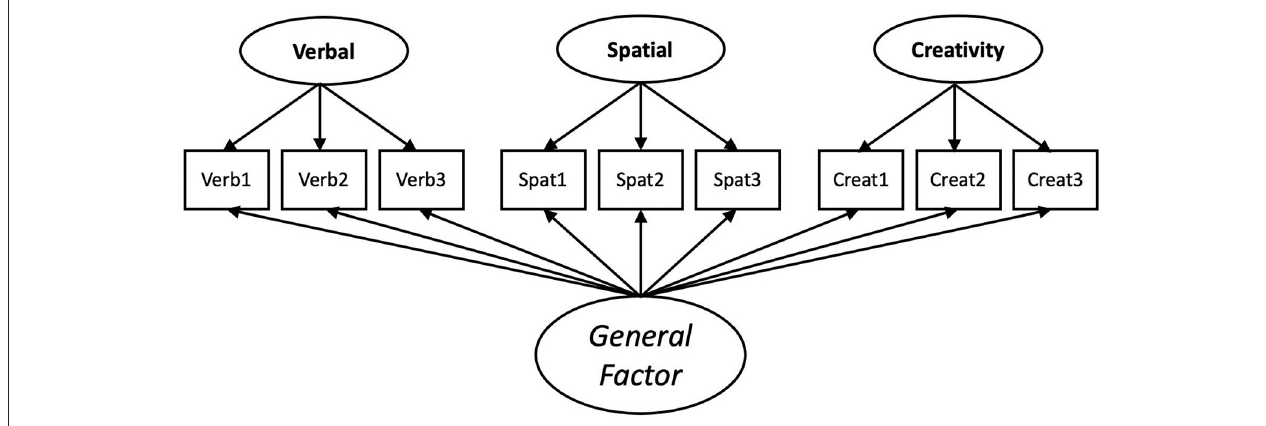
FIGURE 2 | Example bifactor model using measures of verbal aptitude, spatial aptitude, and divergent thinking and a general